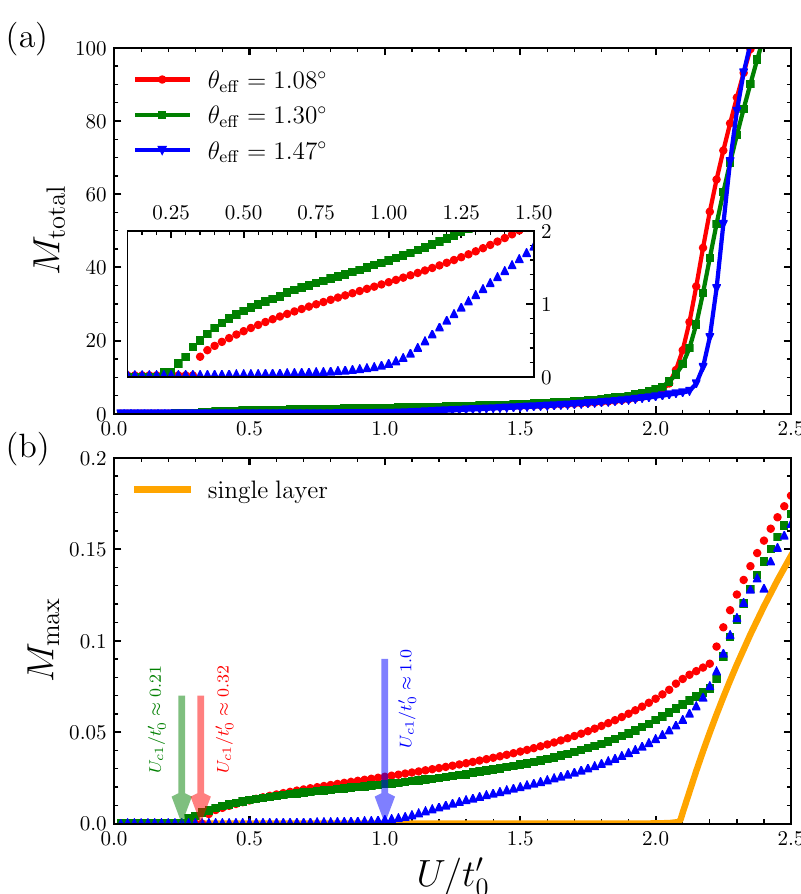
Figure 2: MFT results for the magnetization of the rescaled twisted bilayer system as a function of on-site Coulomb interaction U / t (cid:48) . Panels (a) and (b) show the total 0 = 868 moiré cell and its maximum, respectively. For magnetization per effective N c comparison, results for a single graphene layer with the same intralayer hopping parameters are also shown in panel (b). In panel (b), red, green, and blue arrows = 1.08 ◦ , θ = 1.30 ◦ , and θ = 1.47 ◦ , mark the critical points for θ eff eff eff